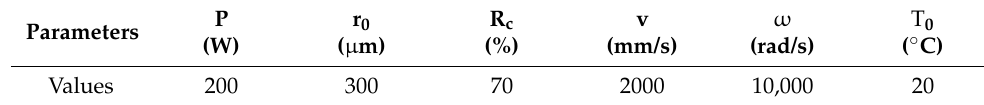
Table 2. Parameters used to simulate temperature field during laser processing.